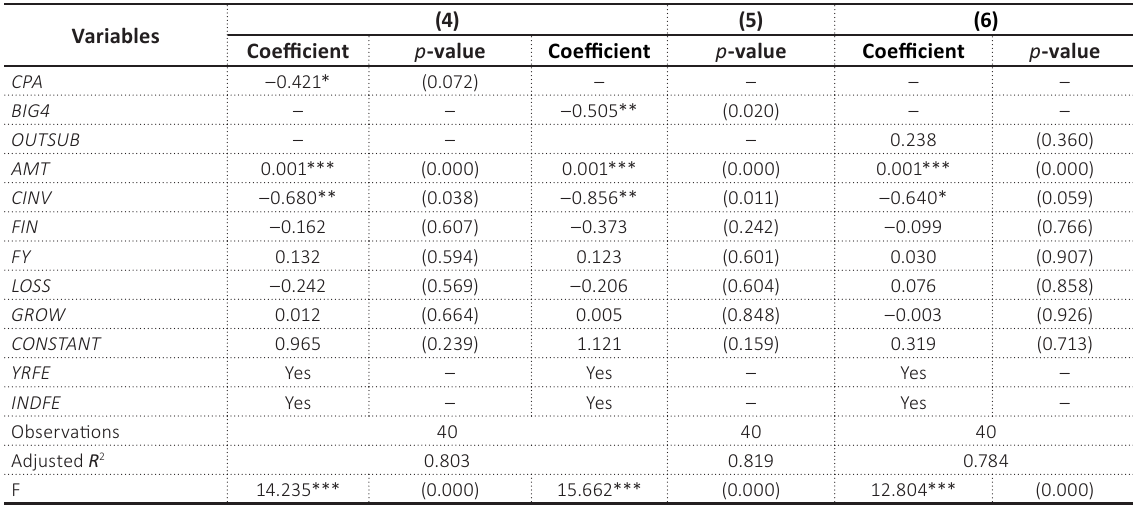
Table 7. Main results for H2 ( DA and external corporate